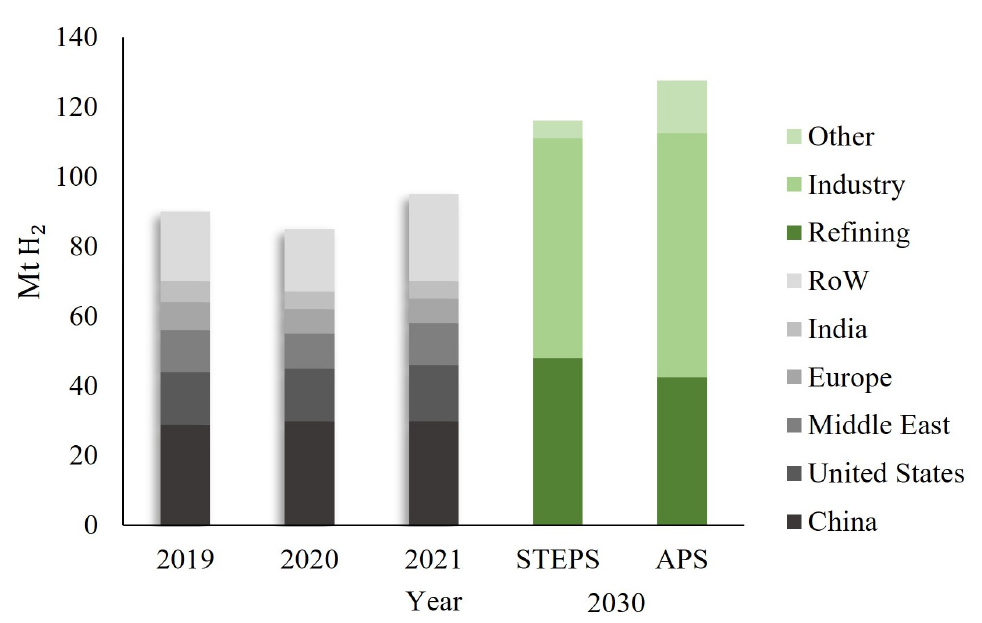
Figure 2. Hydrogen demand by sector and by region according to [45],